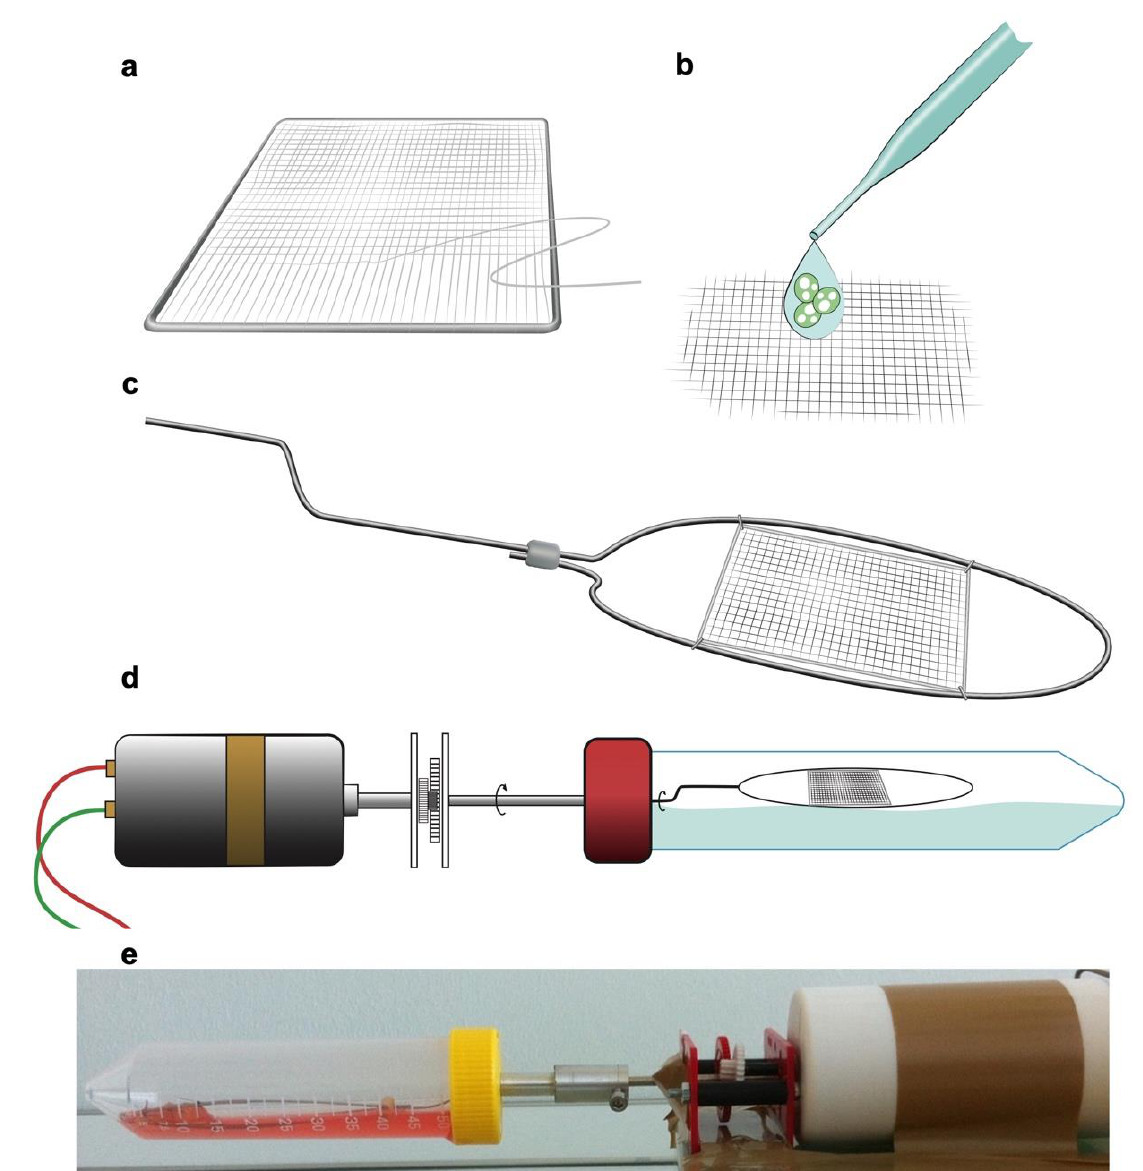
Figure 1. Scaffold and bioreactor construction. ( a ) Spider silk was manually sewn and woven in a parallel design on stainless-steel frames orthogonal to the run of the silk. ( b ) C2C12 myofibroblast cells were seeded and cultured on the spider silk scaffold. ( c , d ) Constructed and seeded scaffolds were mounted on a scaffold carrier which was stabilized by steel wires and loaded into a bioreactor with a continuously rotating scaffold carrier which was attached to an external motor, allowing repetitive immersion in the liquid with a speed of 1 rpm. ( e ) Picture of the rotating bioreactor